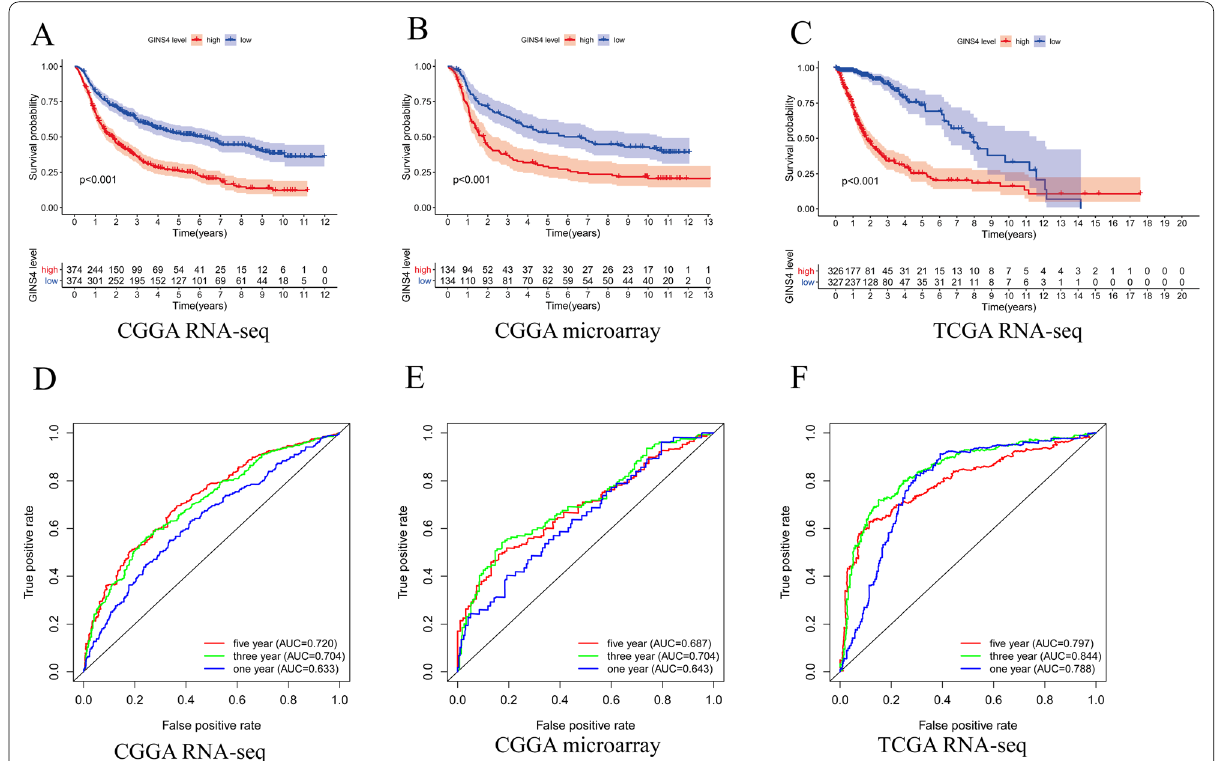
Fig. 4 The relationship between the level of GINS4 and overall survival of glioma patients. A – C The effect of the expression level of GINS4 on overall survival based on the CGGA RNA-seq, CGGA microarray, and TCGA RNA-seq datasets; D – F ROC curves based on CGGA RNA-seq, CGGA microarray, and TCGA RNA-seq